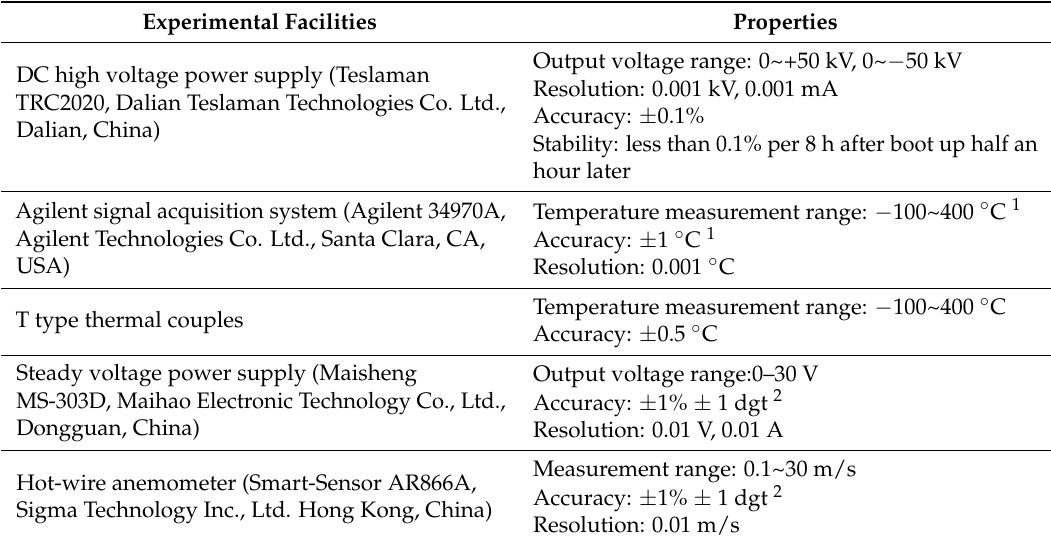
Table 3. Characteristics of the experimental